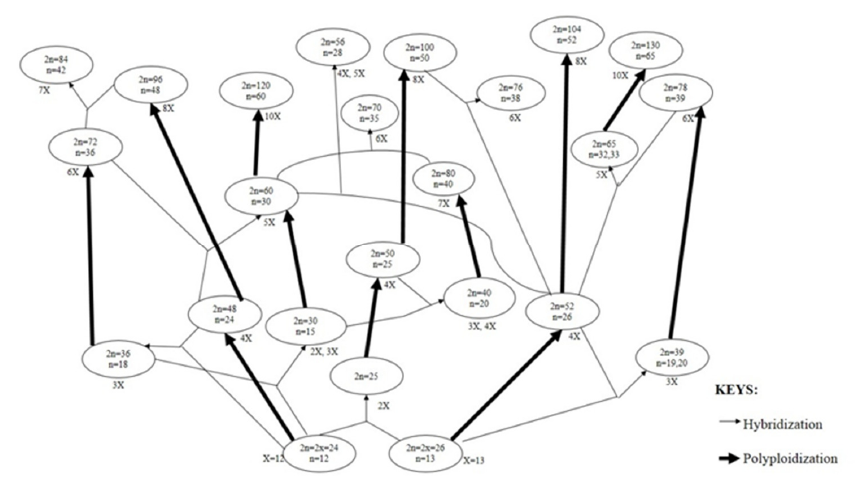
Figure 2. Possible relationship among Ocimum species studied based on present and previous